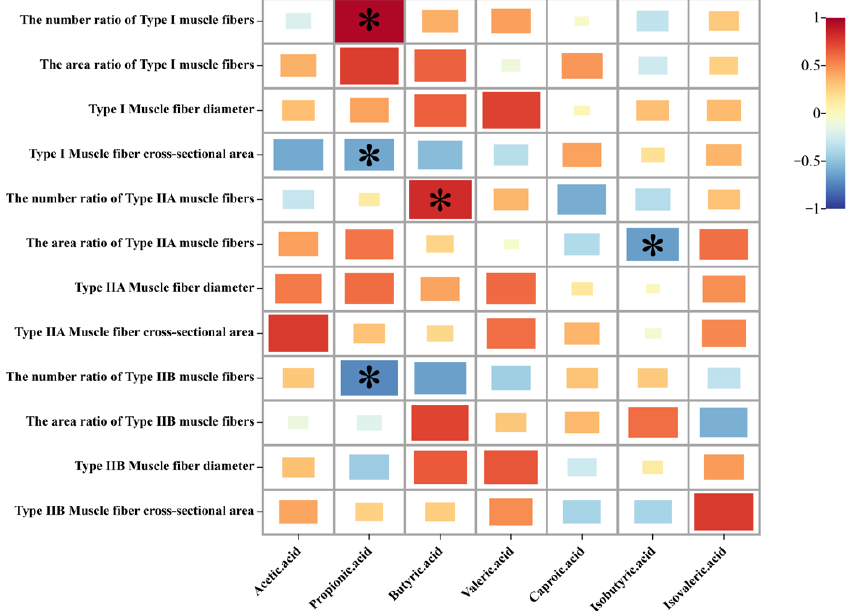
Figure 5. Correlation heat map of intestinal metabolites and muscle fiber types. The color band is mapped to the heat map matrix data; colors close to positive values indicate a positive correlation, while colors close to negative values indicate a negative correlation. * indicates a statistically significant difference ( p < 0.05).